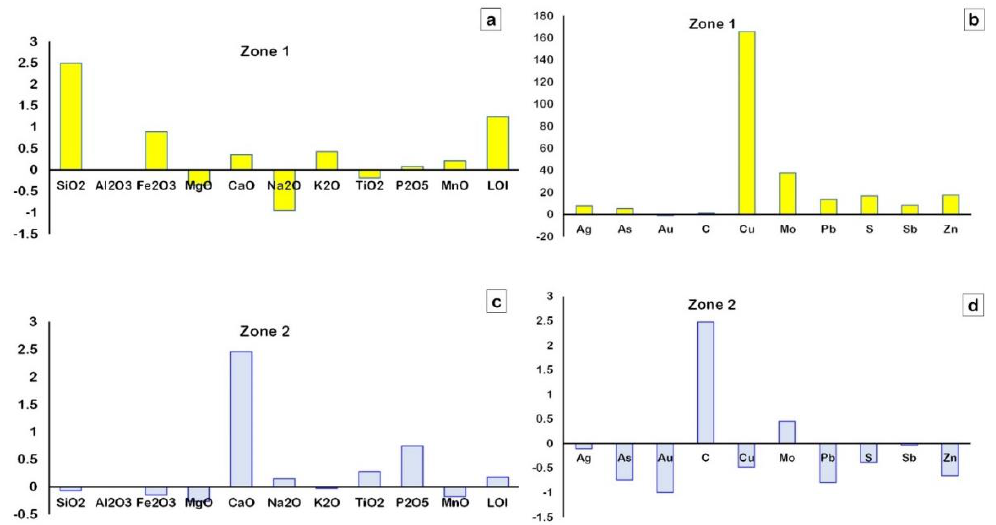
Figure 13. Isocon diagram comparing the mean composition of least-altered samples and altered samples from ( a ) alteration zone-1 (sericite – quartz – chlorite ± kaolinite ± pyrite) and ( b ) alteration zone-2 (calcite – epidote – albite ± chlorite ± sericite).